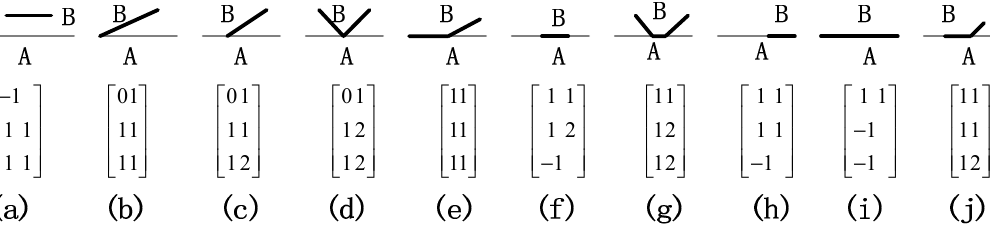
Figure 14. The line/line coarse relations with a single intersection distinguished by the E-WID model. (a ) Line A and B are disjoint; ( b ) The zero-dimensional intersection is on the boundary of both line A and B ; ( c ) The zero-dimensional intersection is inside of line B and on the boundary of line B ; ( d ) The zero-dimensional intersection is inside of both line A and B ; ( e ) The one-dimensional intersection contains one endpoint of line A and one endpoint of line B ; ( f ) Line B is contained in line A ; ( g ) The one-dimensional intersection is inside of both line A and B ; ( h ) Line B is covered by line A ; ( i ) Line A is equal to line B ; ( j ) The one-dimensional intersection is inside of line A and contains one endpoint of line B .